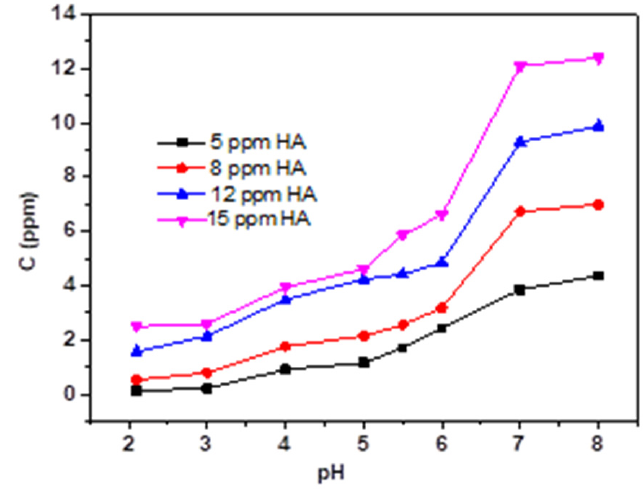
Figure 7. The HA concentration at the end of the experiment as a function of pH.